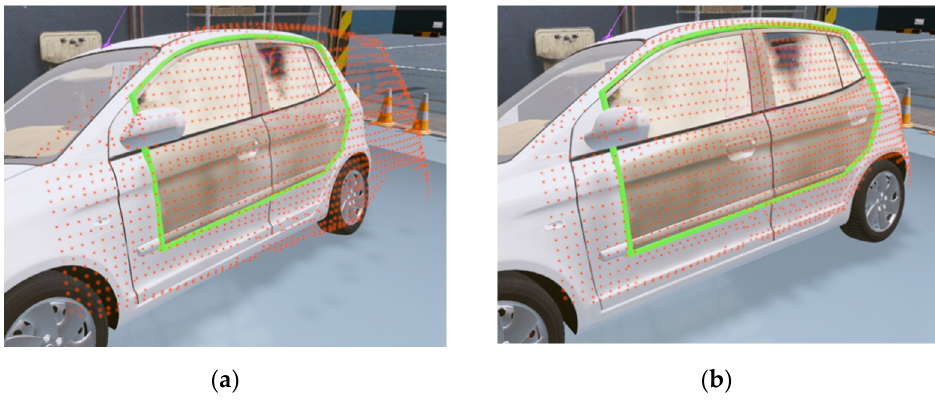
Figure 9. Sample points matched: ( a ) Before; ( b ) After.